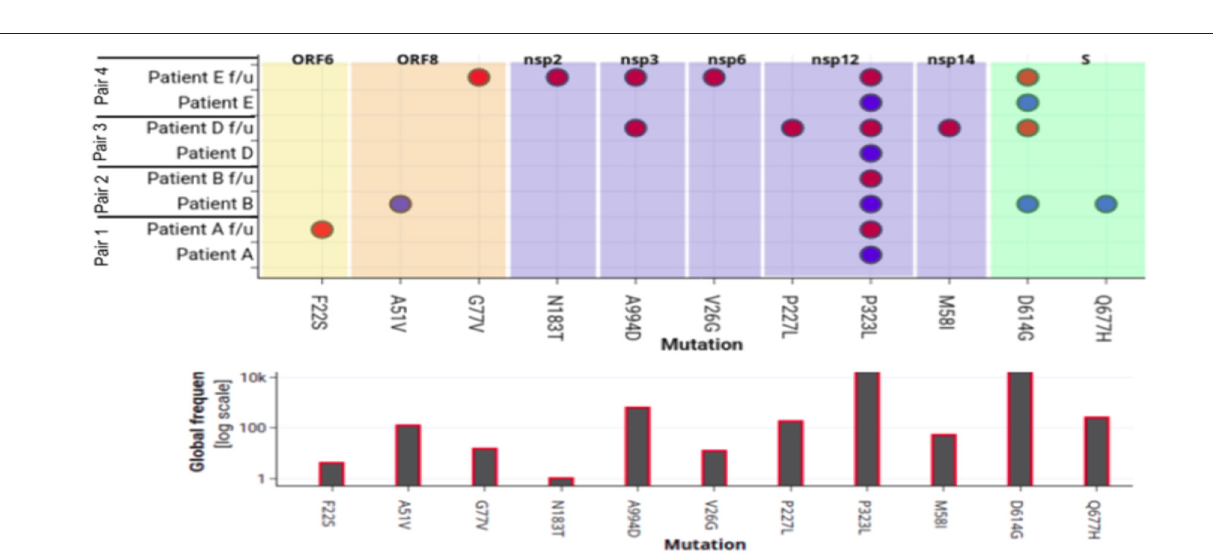
FIGURE 4 | Mapping of amino-acid substitutions within SARS-CoV-2 genome of four pairs of samples. The upper plot demonstrates the seven proteins in different colors that harbor 12 non-synonymous mutations shown in dots. The Y-axis shows the four pair of patient samples. The blue and red dot indicates the presence of the mutation in the first and second episode of infections respectively. The lower plot shows the frequency of that particular mutation in 82,927 genomes deposited in